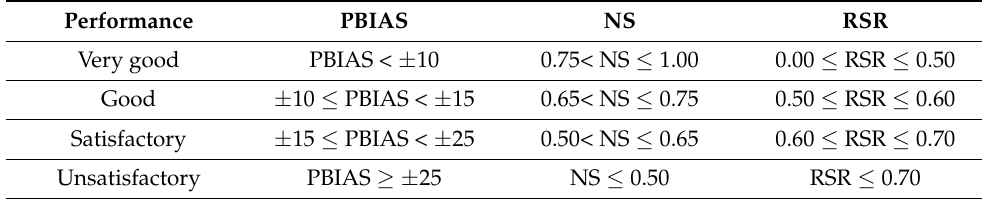
Table 1. Statistical metrics for assessment of the SWAT model in a monthly time